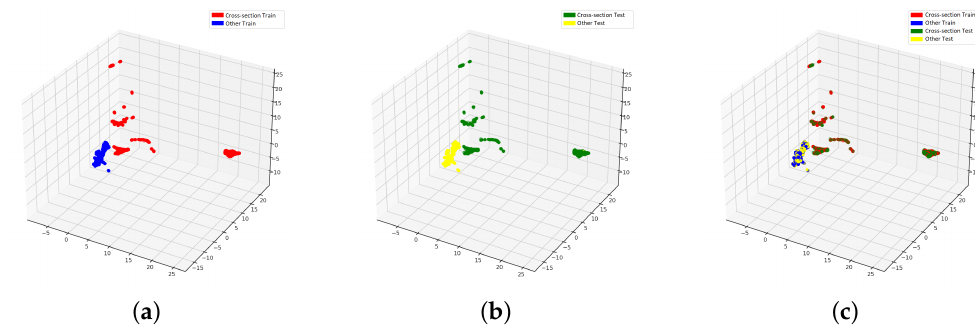
Figure 5. UMAP embedding space of Xception on training and test set. ( a ) shows cross-section and other labeled data from the training set, ( b ) shows cross-section and other labeled data from test set, ( c ) illustrates both labeled train and test data points in the same representation space.